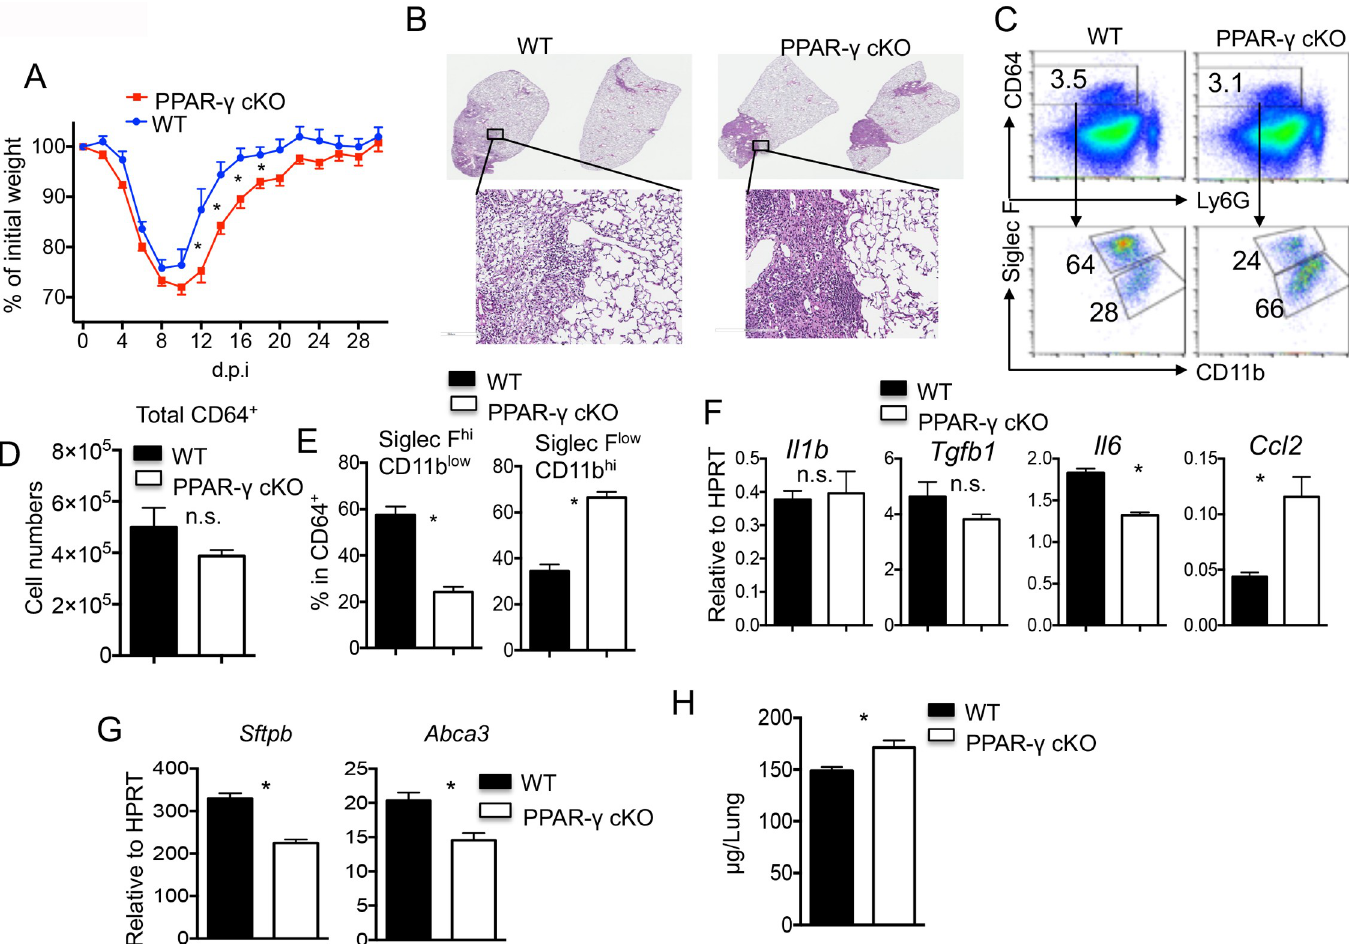
Fig 1. Myeloid PPAR- γ deficiency causes impaired lung inflammation resolution and enhanced collagen deposition. WT ( Pparg fl/fl ) or PPAR- γ cKO ( Pparg Δ Lyz2 ) mice were infected with influenza virus. Mice were sacrificed for various analysis at 30 d.p.i. ( A ) Host morbidity (% of initial weight) was monitored every other day till 30 d.p.i. ( B ) H.E stainning of lung sections collected from WT or PPAR- γ cKO mice. Low magnitude of whole left lung section image and high magnitude of indicated section images are depicted. ( C ) Lung cells from WT or PPAR- γ cKO mice were stained with CD64, Ly6G, Siglec F and CD11b and analyzed by flow cytometry. CD64 + macrophages were then subdivided into Siglec F hi CD11b low and Siglec F low CD11b hi populations. ( D ) Total numbers of CD64 + macrophages in the lungs from WT or PPAR- γ cKO mice were enumerated by flow cytometry. ( E ) Percentages of Siglec F hi CD11b low or Siglec F low CD11b hi macrophage populations were determined by flow cytometry. ( F ) Il1b , Tgfb1 , Il6 and Ccl2 gene expression levels in the lungs from WT or PPAR- γ cKO mice were determined by realtime RT-PCR. ( G ) ATII gene, Sftpb and Abca3 , expression levels in the lungs from WT or PPAR- γ cKO mice were determined by realtime RT-PCR. ( H ) Collagen content in the lungs from WT or PPAR- γ cKO mice was measured by Hydroxyproline assay. Data are representative of at least two independent experiments (n = 2–4 mice/group/experiment). Statistical differences are indicated. � , P < 0.05 (two tailed